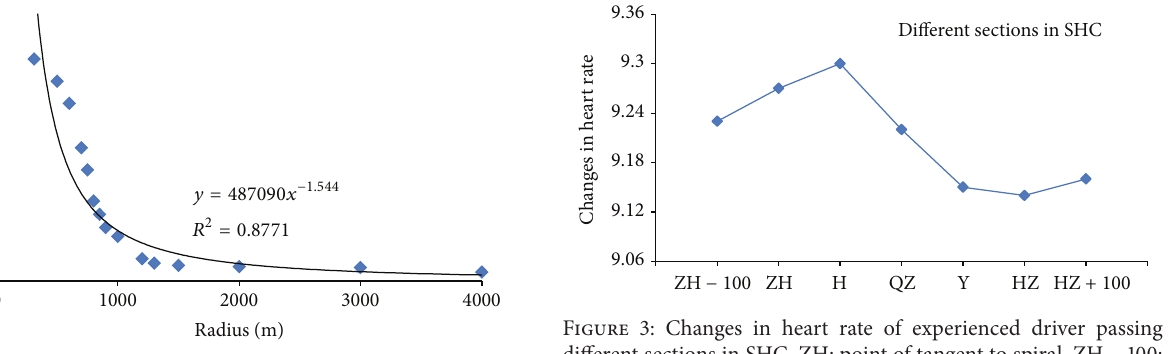
Figure 1: Relationship between crash frequency and radius of expressway plane curves.